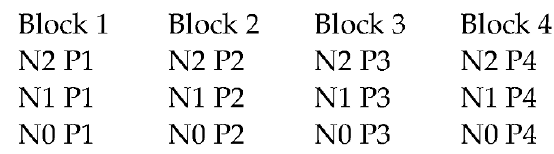
Figure 1. Experimental design. Table 1. The amount of N min (kg ha − 1 ) of the field trails in 2014 and in 2015.